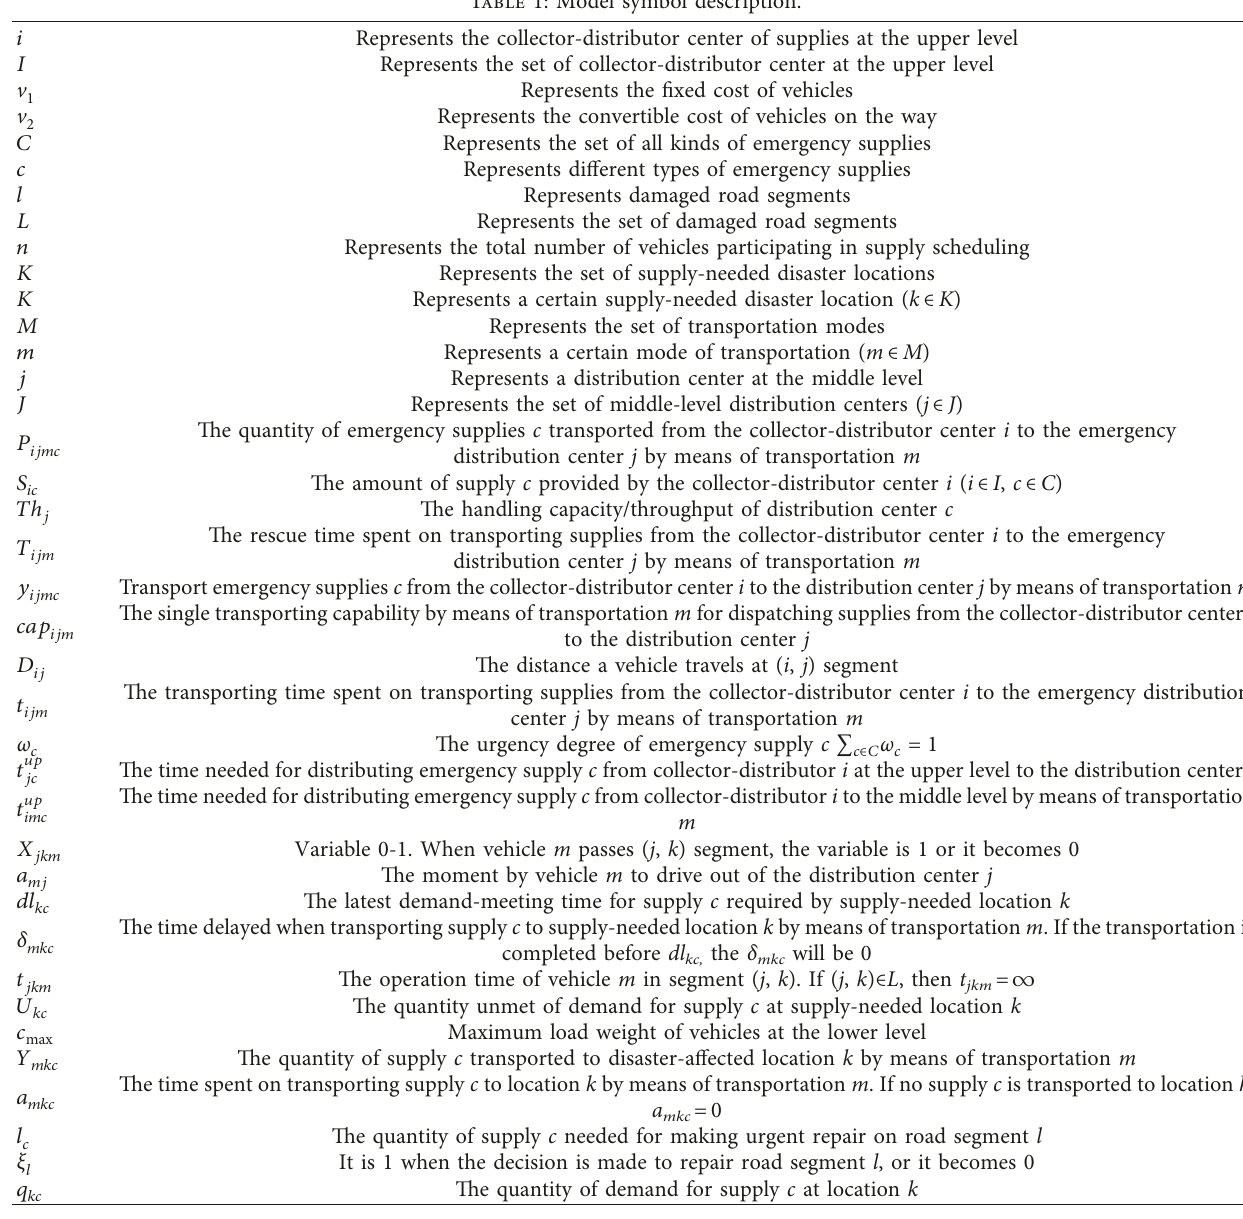
Figure 3: Different road network status (partial). (a) Repair all. (b) Partial repair. (c) Not repaired all. Table 1: Model symbol